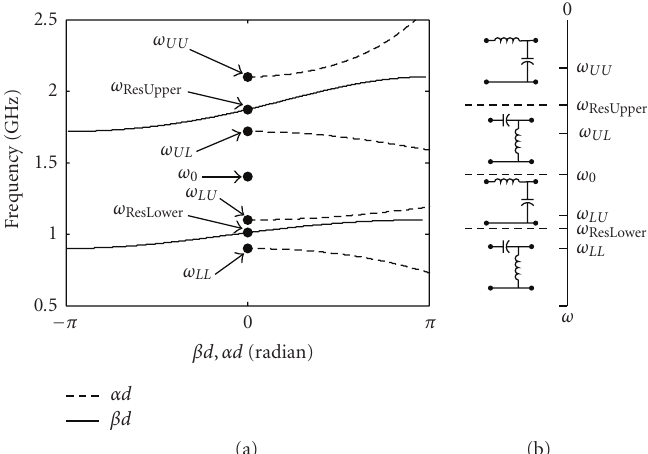
Figure 2: The dispersion (a) and equivalent circuits (b) of the extended CRLH transmission line ( β and α are defined in (9) and (10).)